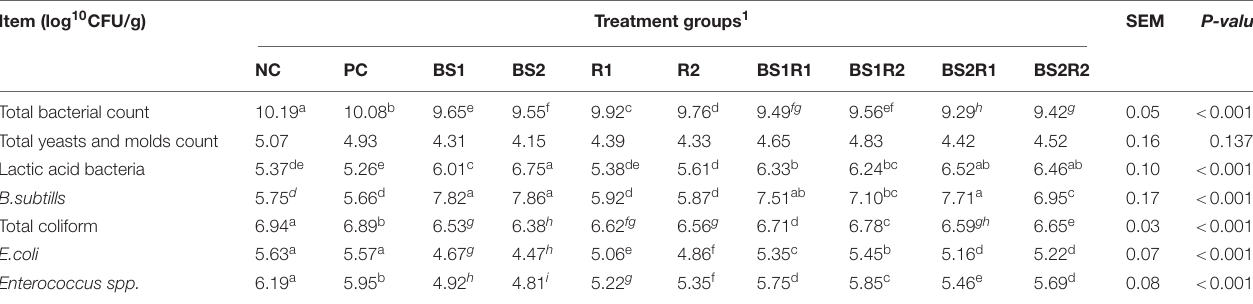
TABLE 5 | Effect of in ovo inclusion of Bacillus subtilis , raffinose, and their synbiotics on cecal microbial population of 21-day-old broilers. Item (log 10